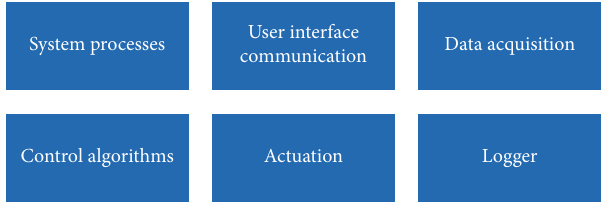
Figure 3: System software